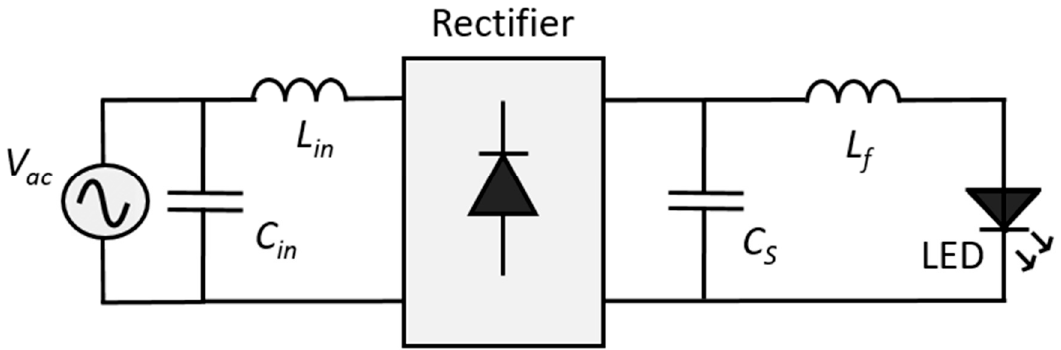
Figure 2. Typical application of a passive “lossless” LED driver.